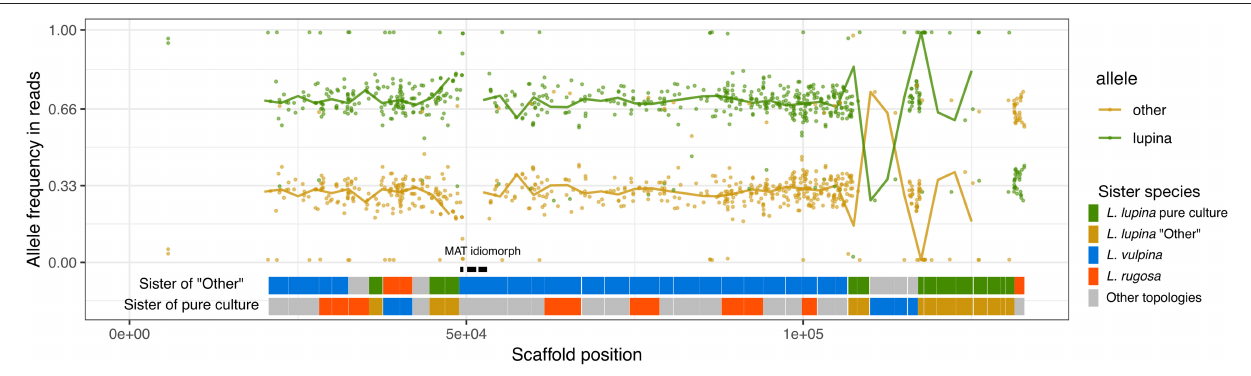
FIGURE 6 | Allele frequencies and ancestry of the L. lupina metagenome variants around the MAT locus. The L. lupina pure culture was used as reference to classify each allele as either “lupina” (reference) or “other” (alternative). Points represent the raw allele frequency at each site, while the solid lines connect the median allele frequency of non-overlapping 2.5 kb-long windows. Sites and windows overlapping with repetitive elements were discarded (missing data). The genes within the MAT1-1 locus are marked with black rectangles. Below the allele frequencies, two horizontal bands represent the inferred sister of the “other” (upper band) and “lupina” (lower band) components across the contig, inferred from genealogies of non-overlapping windows of 50 SNPs each. Genealogies were rooted with L. columbiana .